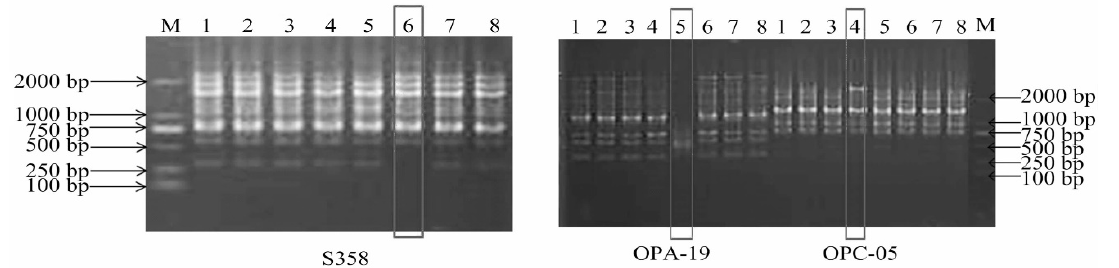
Figure 1. RAPD identification results. Band M was marker, number 1 to 8 were at NaCl concentrations